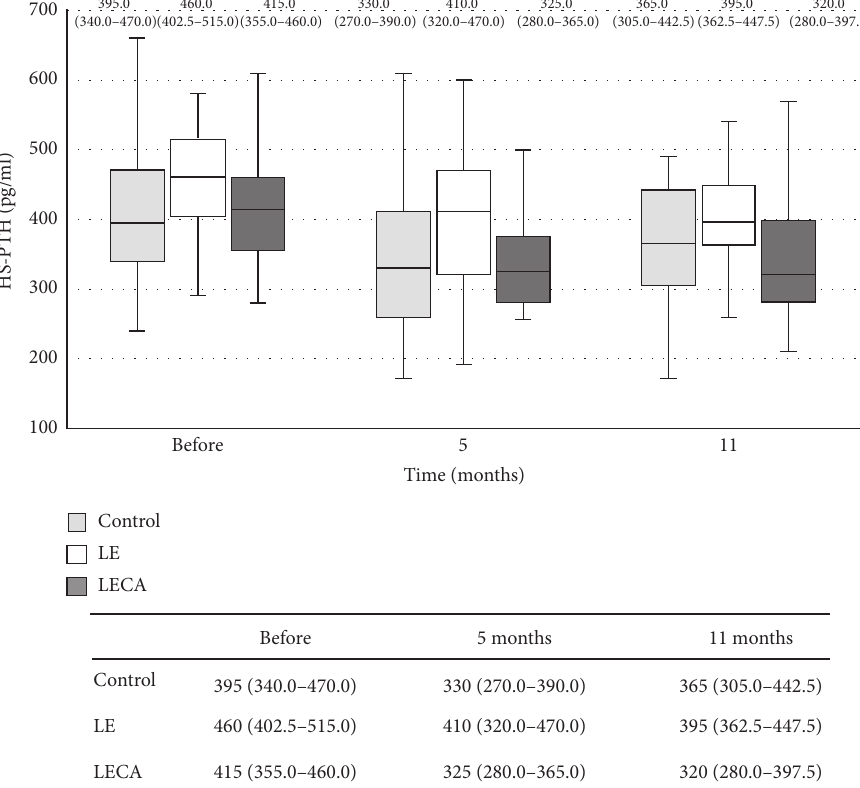
Figure 5: Changes in HS-PTH concentrations in each group (chronological). Values are shown as the median (interquartile range) (25%– 75%) with error bars. Light grey box is the control group, blank box is the LE group, and dark grey box is the LECA group. Friedman’s test with type of ingested product and intervention period as factors was used. p values for each group are shown ( ‡ ). Control: p � 0.003 ‡ ; LE: p < 0.001 ‡ ; LECA: p < 0.001 ‡ . HS-PTH: highly sensitive parathyroid